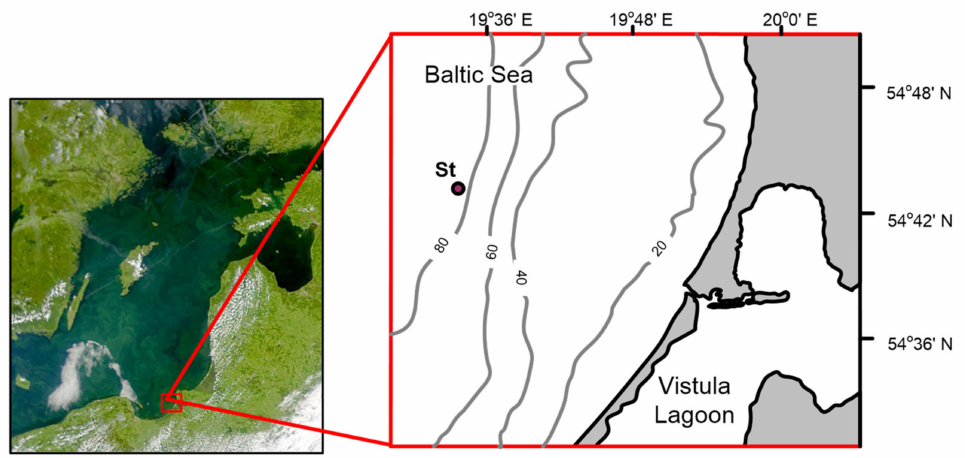
Figure 1. Research area and station